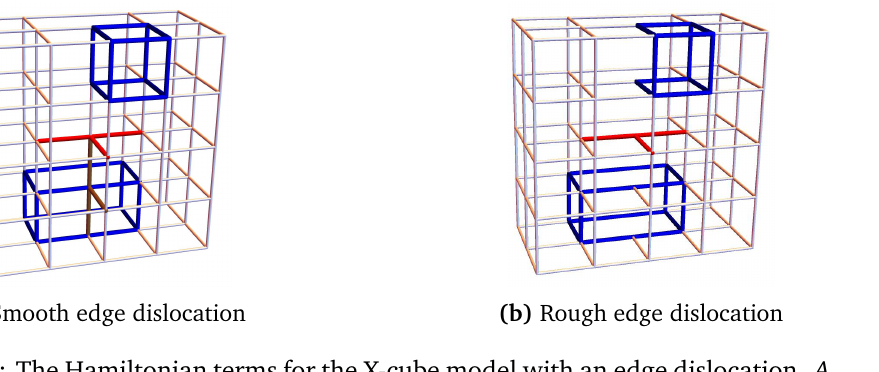
Figure 19: The Hamiltonian terms for the X-cube model with an edge dislocation. A B z , and B x terms near the defect are highlighted in blue, red and brown respectively. v v The rough edge dislocation only has one vertex term on vertices on the defect